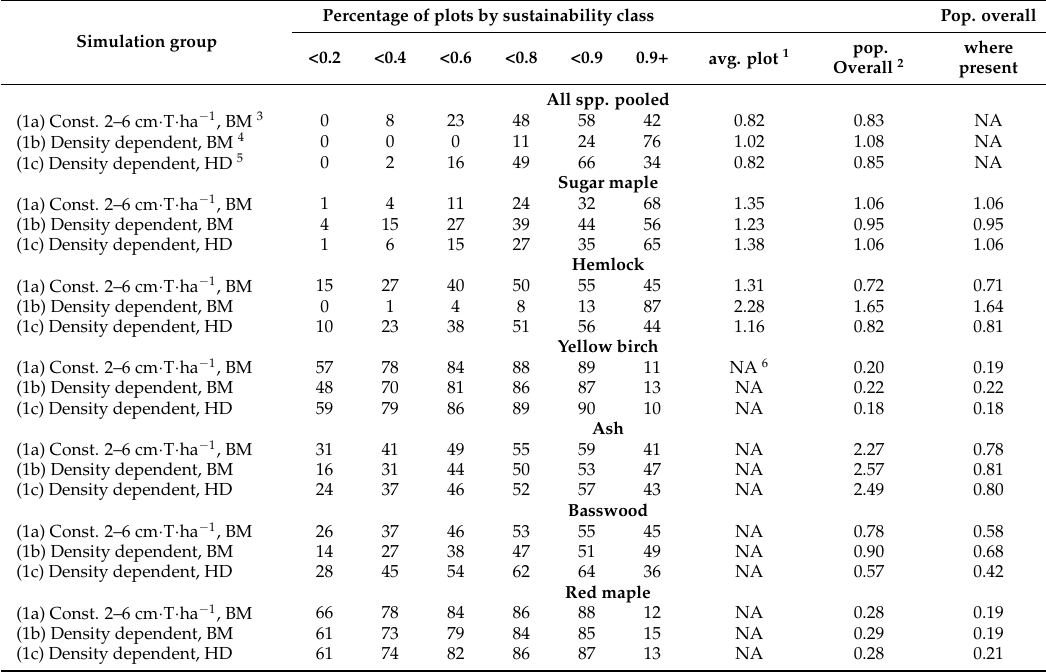
Table 2. Summary of demographic sustainability index values from simulations of the 70 upper Michigan field plots, showing the effect of recruitment limitation and disturbance regime (Group 1 simulations). Ten replicates of each plot were simulated for 500